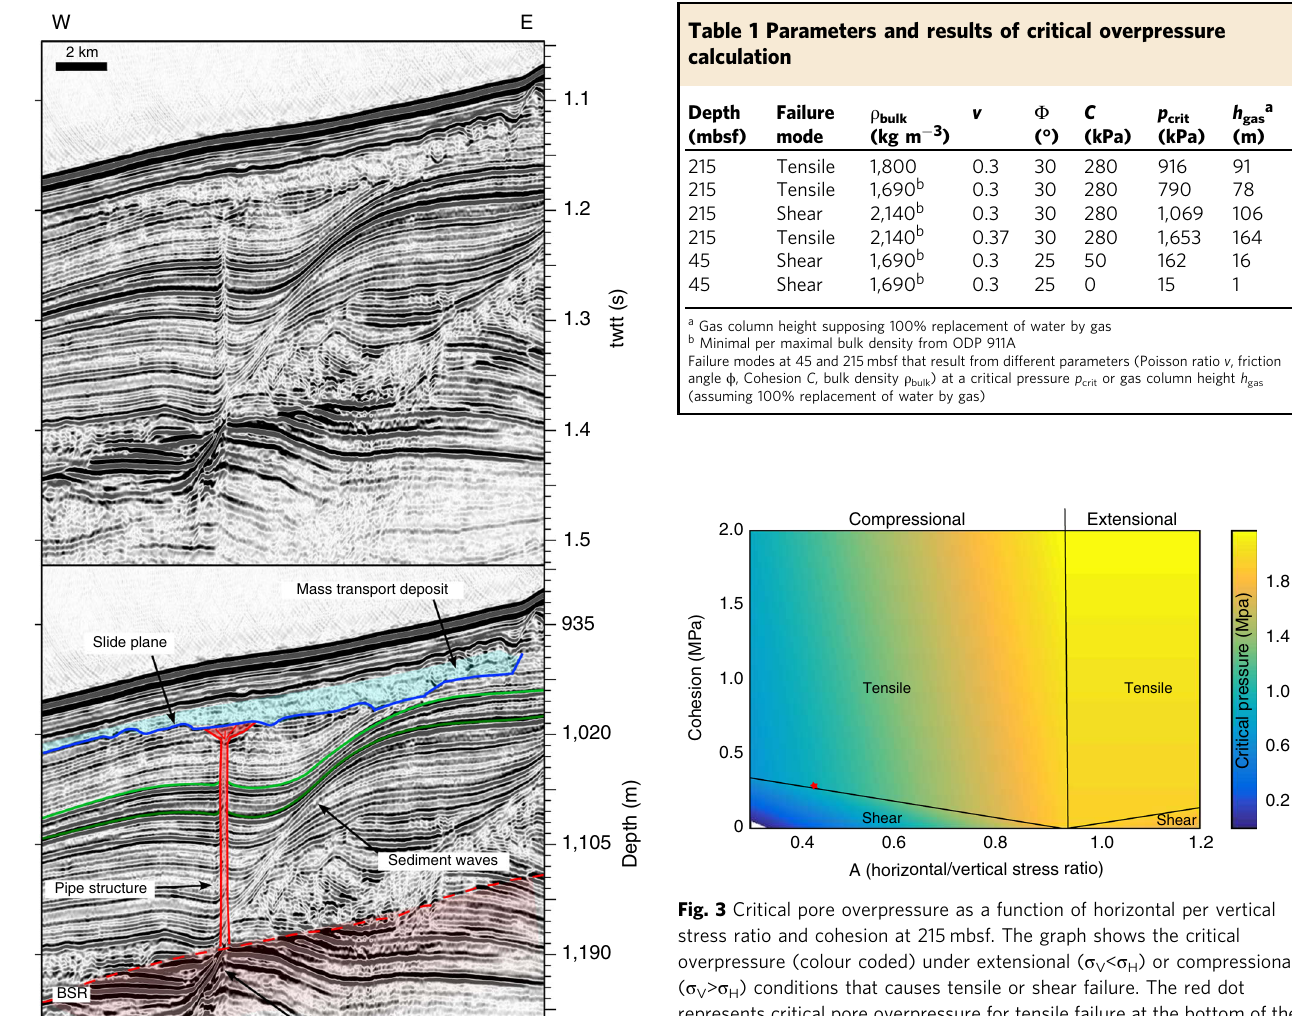
Fig. 2 Re fl ection seismic pro fi le and its interpretation with pipe structure and mass transport deposit. An extract of pro fi le 20130390 without interpretation at the top (location in Supplementary Fig. 1) showing parallel re fl ections and bodies without visible internal structure, and its interpretation at the bottom showing strati fi ed layers, headwalls (black lines), two highlighted colour-coded re fl ectors (green), the slide plane (blue) with the mass transport deposit (light blue), and a pipe structure reaching from the BSR to the mass transport deposit with the free gas below (red). The assumed sediment sound velocity for depth calculation is